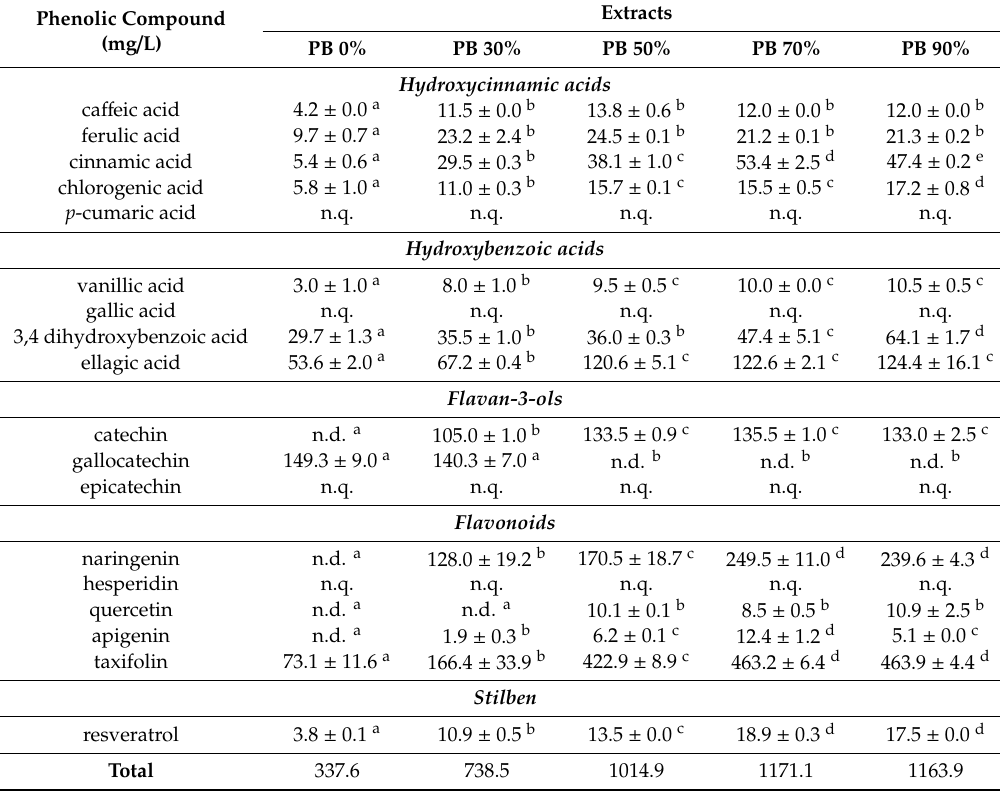
Table 3. Phenolic compounds identification and quantification in aqueous and hydroethanolic extracts from Pinus pinaster